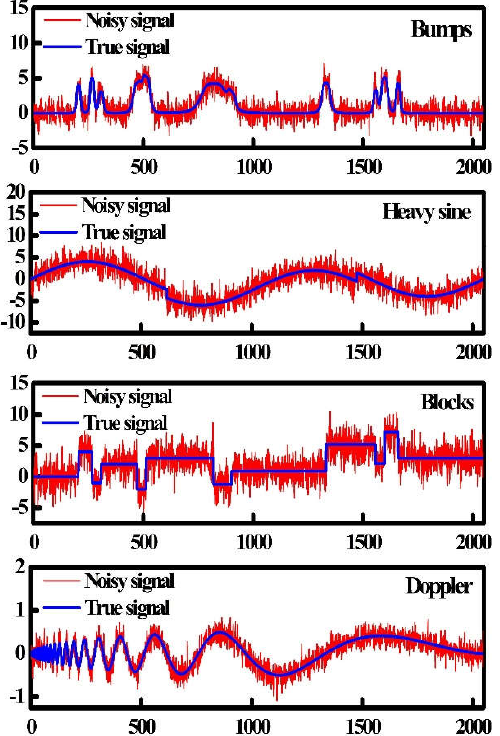
Figure 2. The four types of synthetic signal with SNR in = 5 dB.